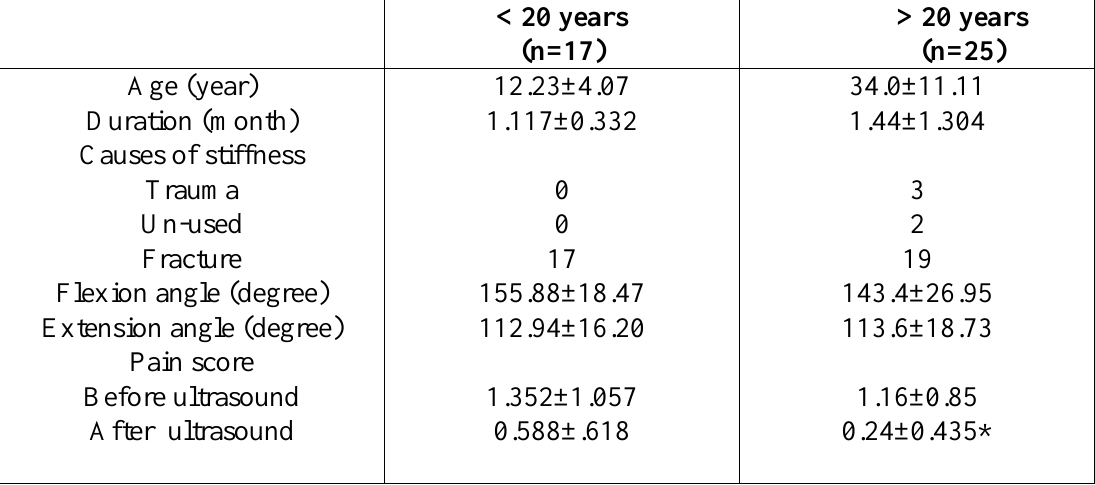
Table 2: Effect of ultrasound therapy on elbow stiffness in considerations the interaction of age and other characteristics.